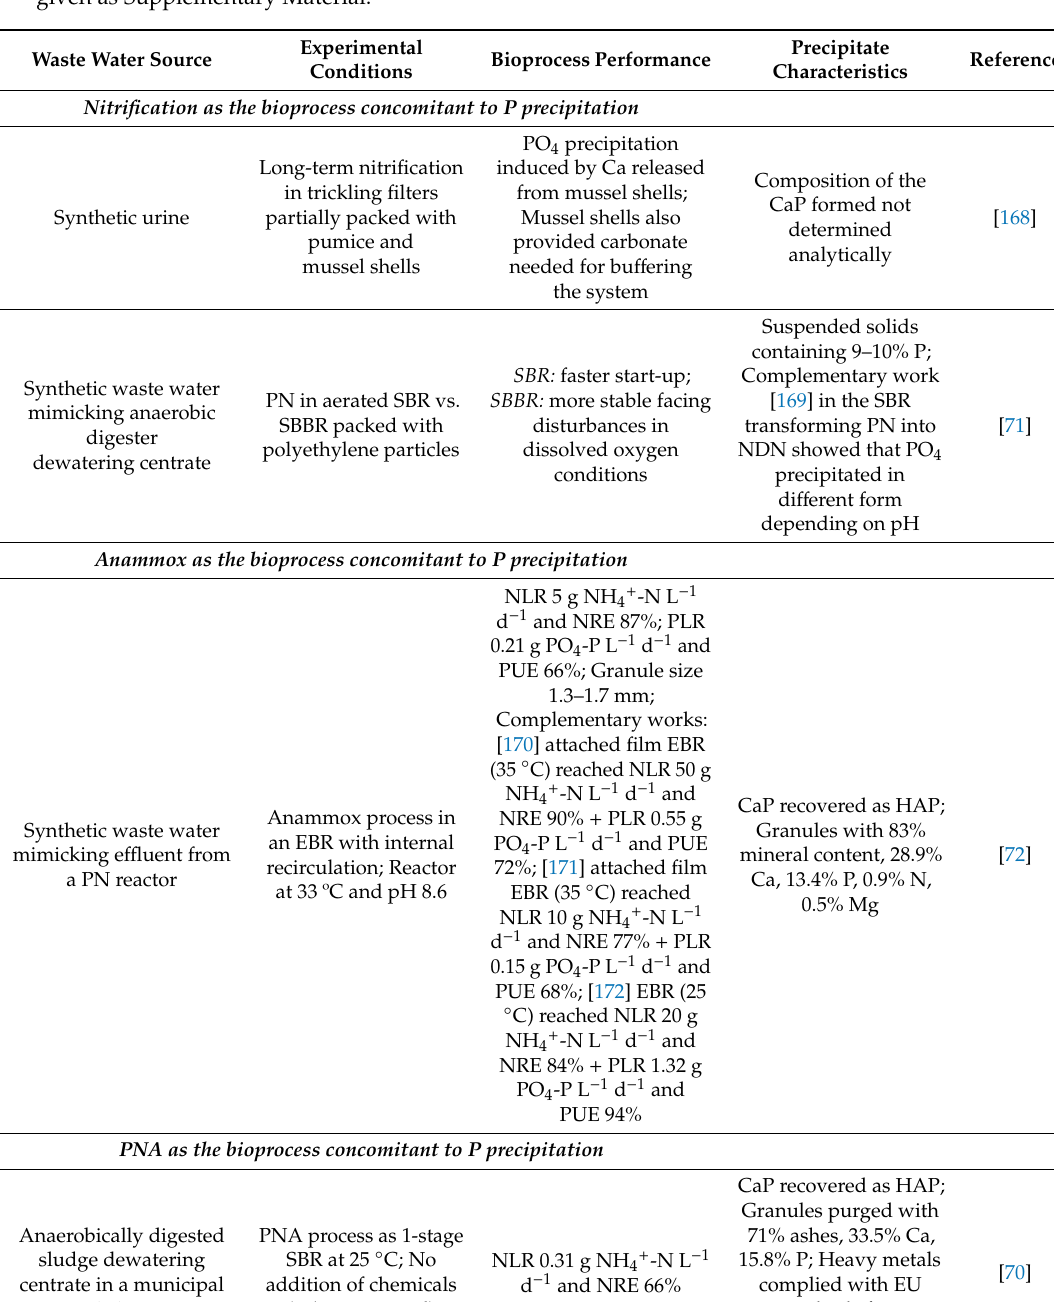
Table 3. Summary of experiences integrating biological N oxidation, or removal, and mineral precipitation aimed at P recovery inside the bioreactor (concomitant precipitation). More details are given as Supplementary